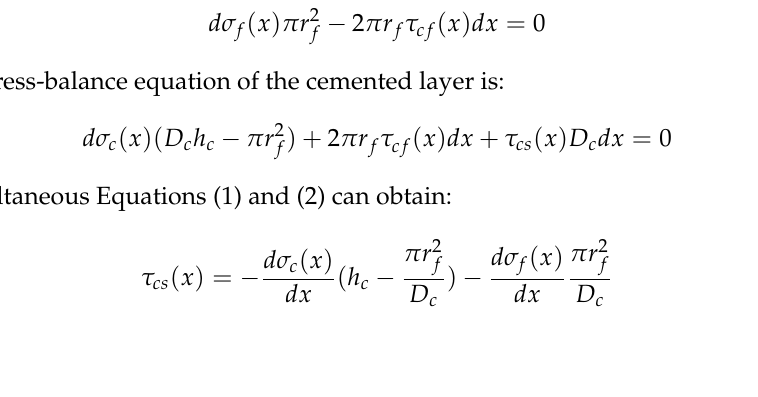
layer, and optical fiber, the strains between each layer are within the elastic range and the